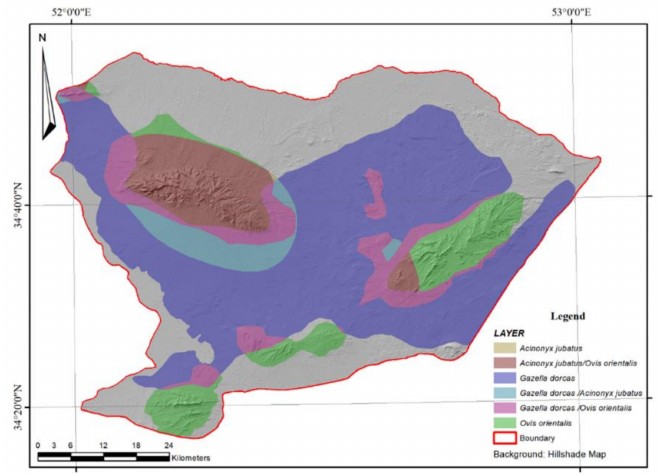
Figure 11. Distribution of di ff erent wildlife species in Kavir National